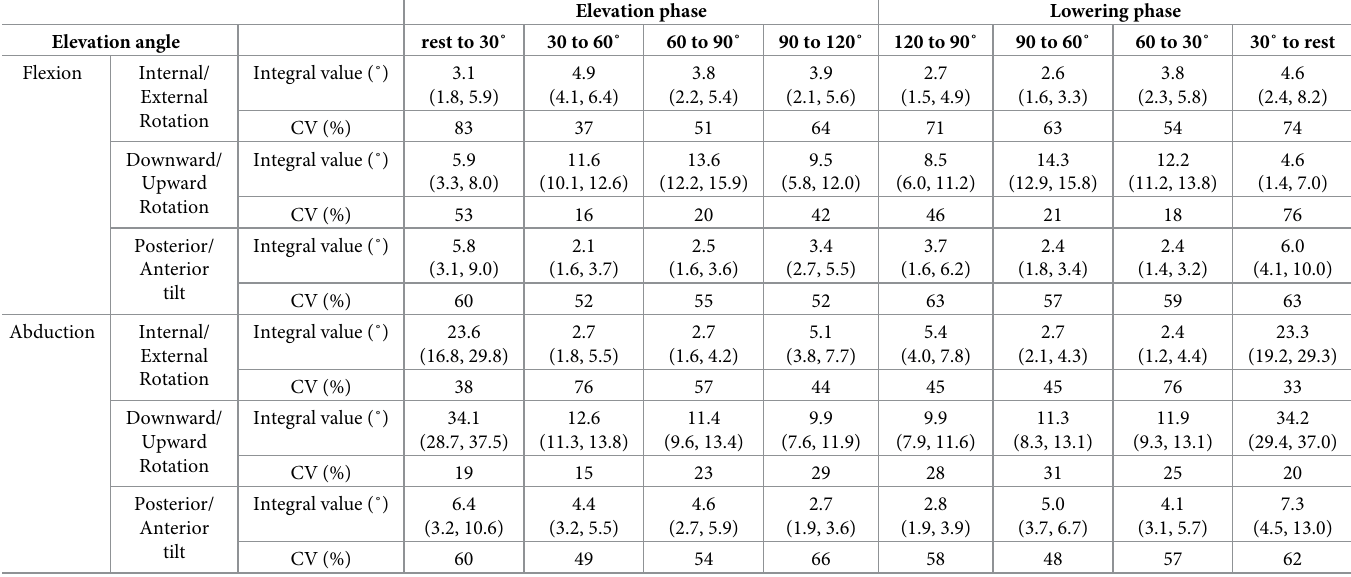
Table 2. Integral value of scapular movement and coefficient of variance.